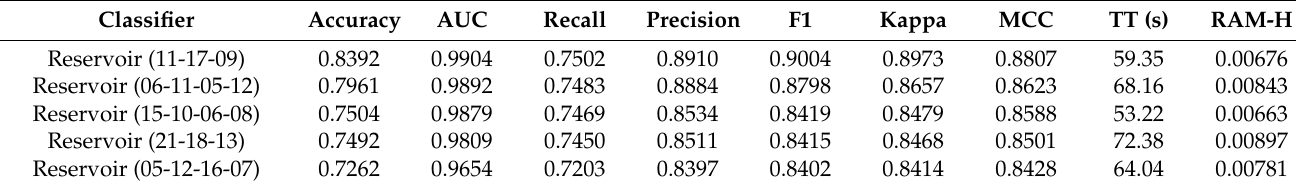
Table 7. Classification performance metrics of the proposed Reservoir